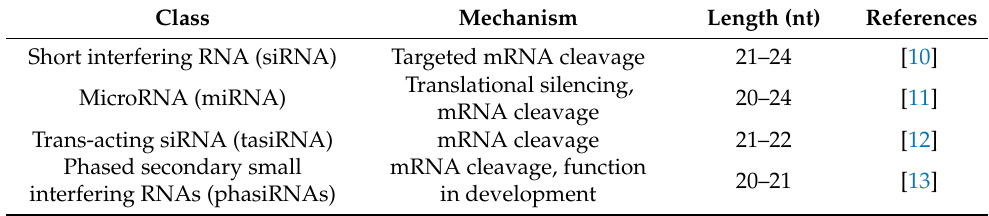
Table 1. Classes of small non-coding RNAs involved in gene silencing in plants. Class Mechanism Length (nt) Short interfering RNA (siRNA) Targeted mRNA